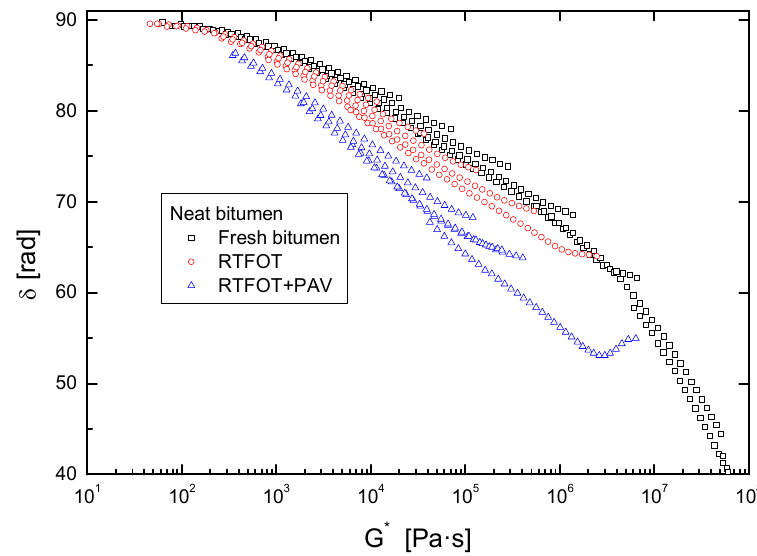
Figure 5. Black diagrams (phase angle, δ , versus complex shear modulus, G* ) of neat bitumen, before and after ageing by RTFOT and RTFOT + PAV.